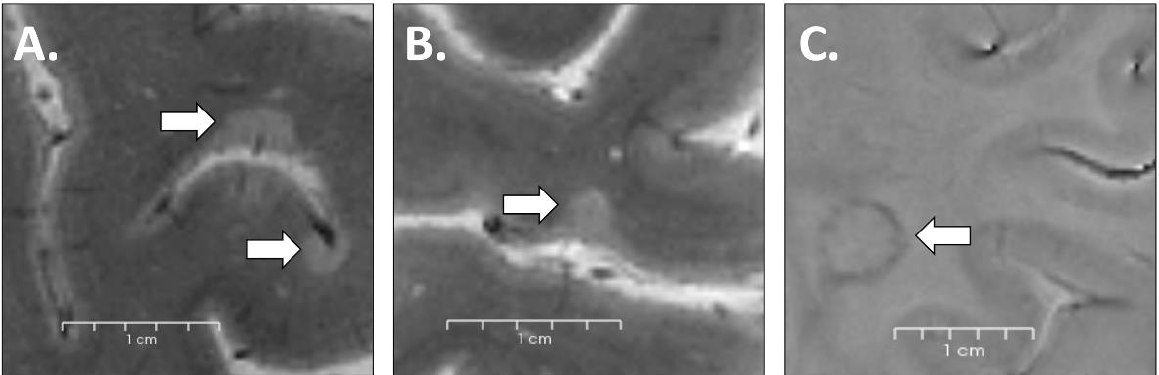
Figure 2. Examples of lesions visible on T2*-w images in a 48-year-old female MS patient (intracortical ( A ) and leukocortical ( B ) lesions identifiable in magnitude imaging; ( C ) rim lesion visible in phase-contrast imaging.